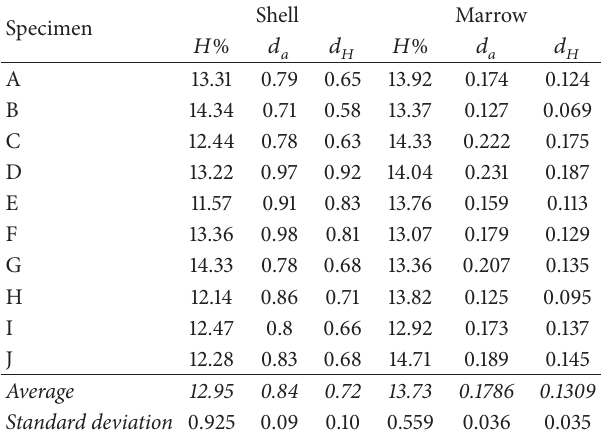
Table 2: Moisture content and density of different